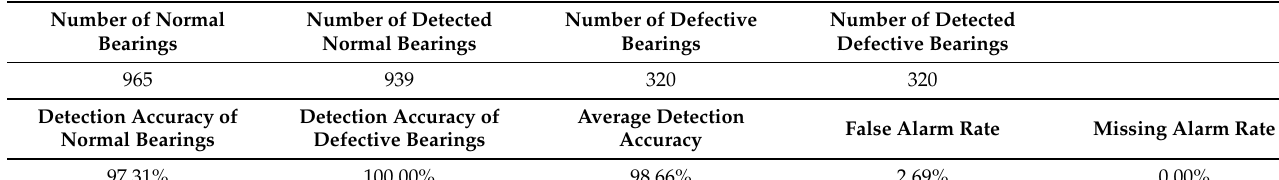
Table 1. Overall results of defect detection.